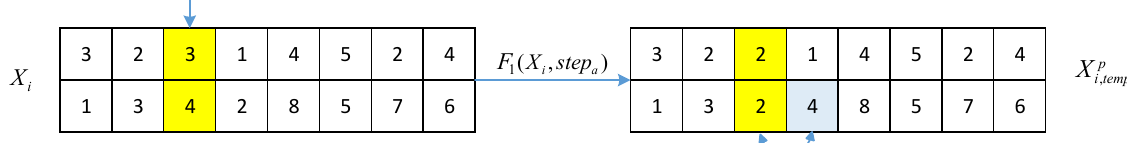
Figure 1. The optimization process of the WPA.